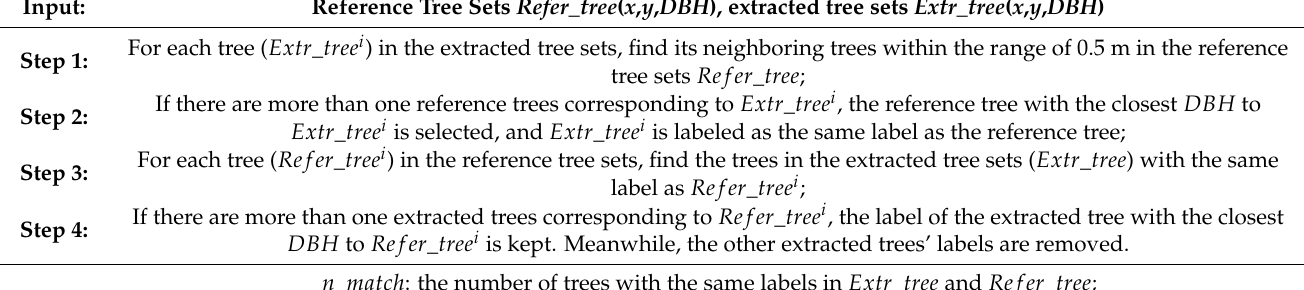
Table 3. Accuracy metrics calculation